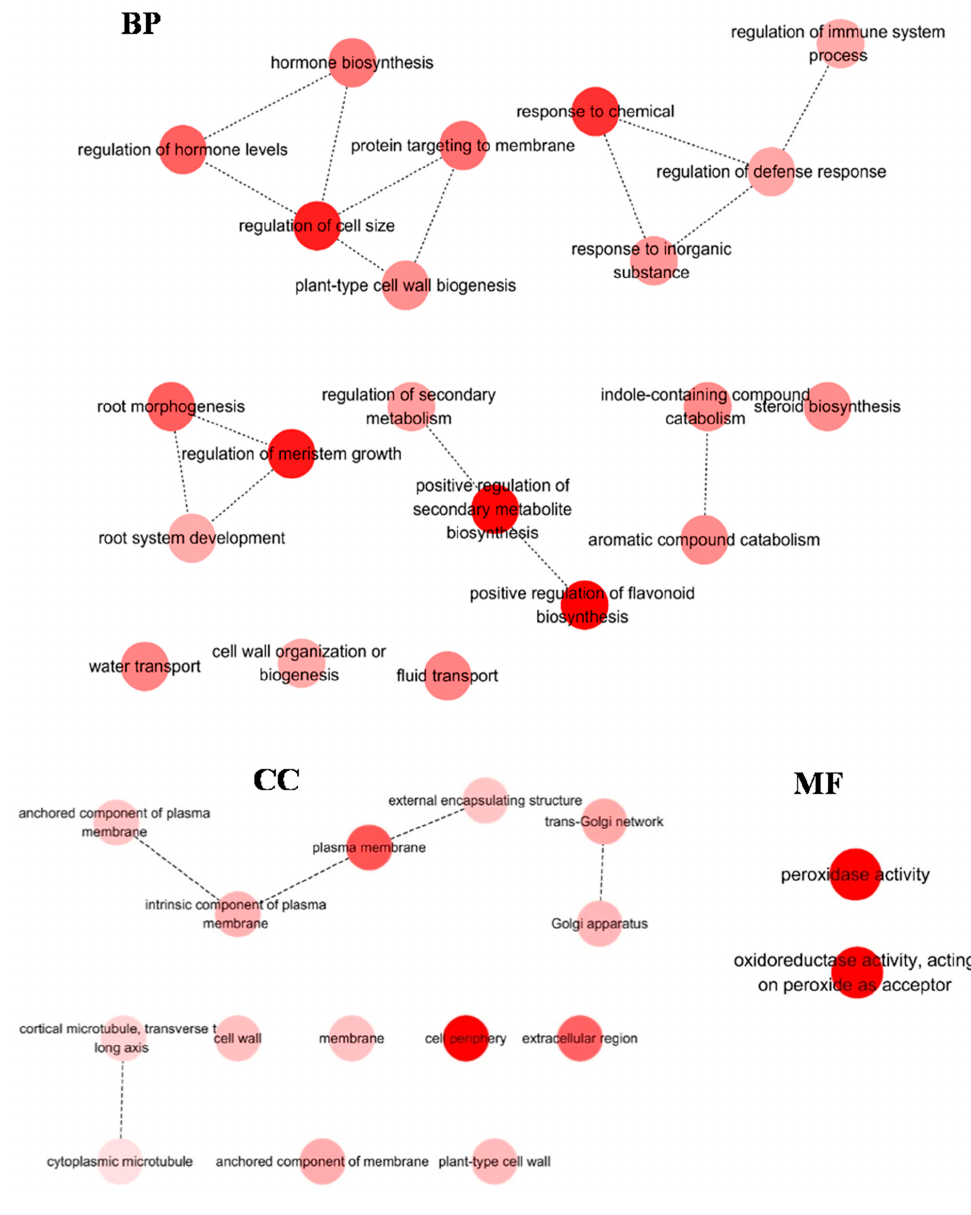
Figure 5. GO terms enrichment analysis of DEGs (24 h) in root. Few GO terms were over-represented in R6 libraries. Therefore, only GO terms enrichment in R24 libraries were displayed. The genes were assigned to three main categories: biological process (BP), molecular function (MF) and cellular component (CC). Node filled color represented p value. White nodes were not significantly over-represented terms.